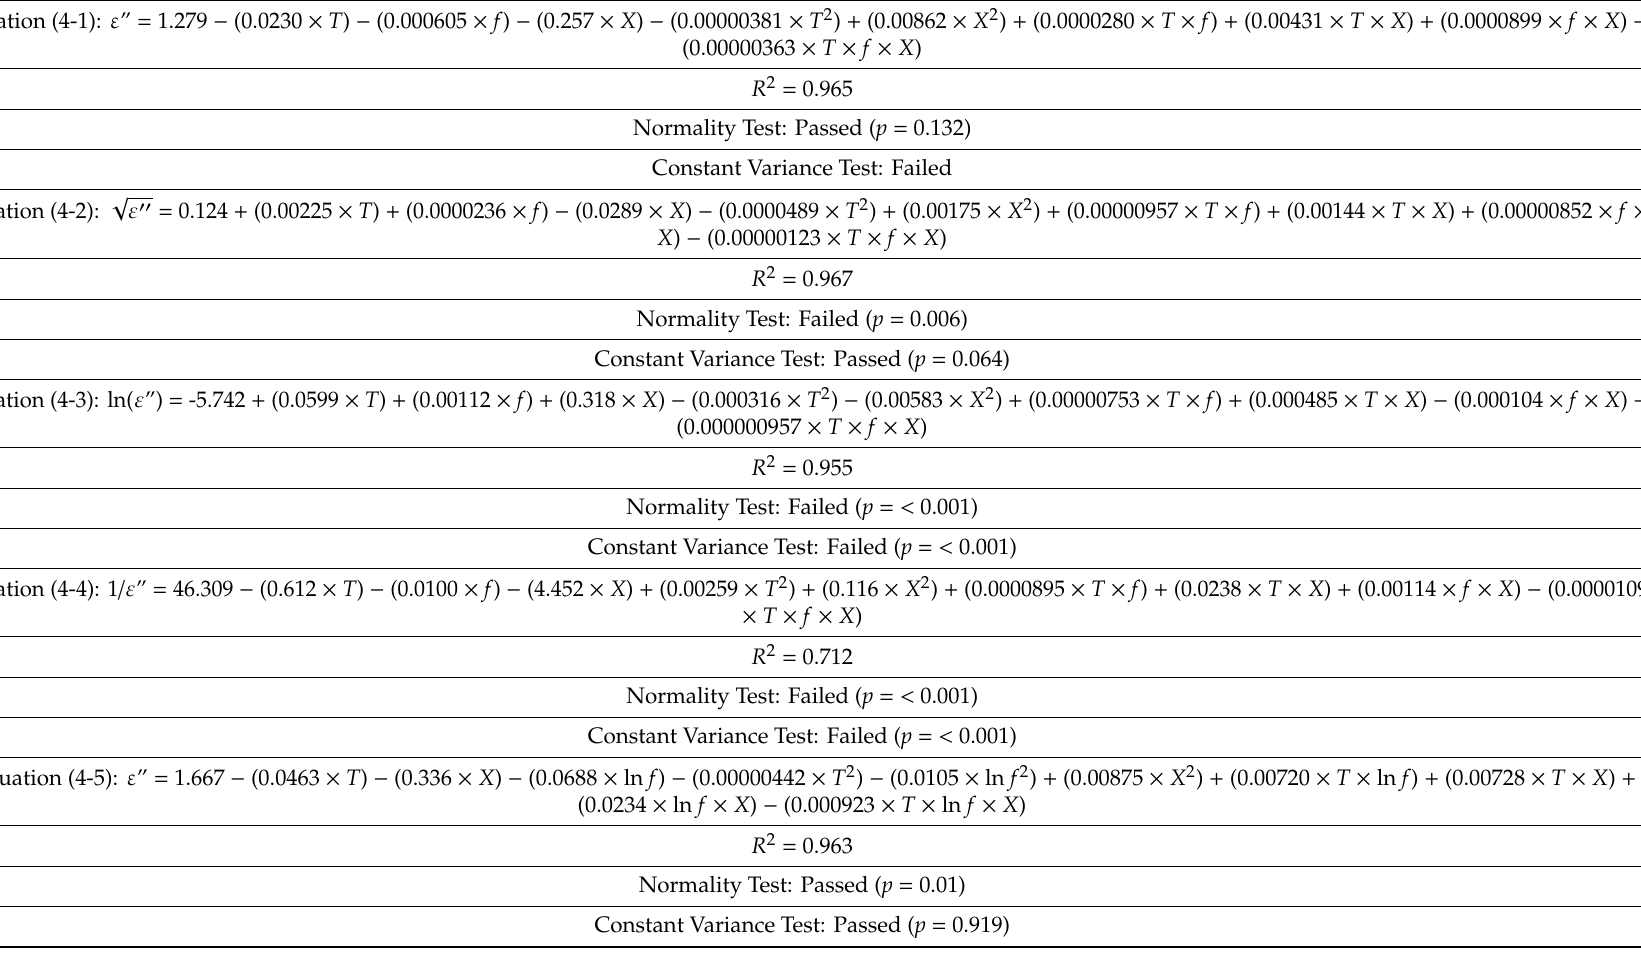
Table 4. The relationship between the loss factor and the influencing factors and statistical criteria established with regression analysis for egg white